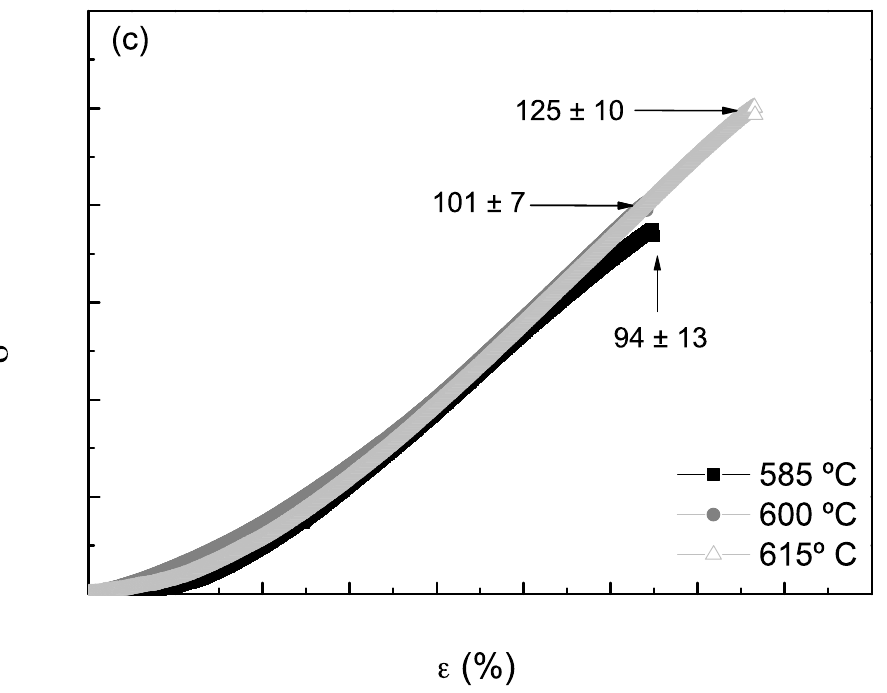
Figure 5. Experimental results of engineering stress-strain values as a function of both sintering time and temperature: ( a ) 0.5 h; ( b ) 1.5 h; and ( c ) 3